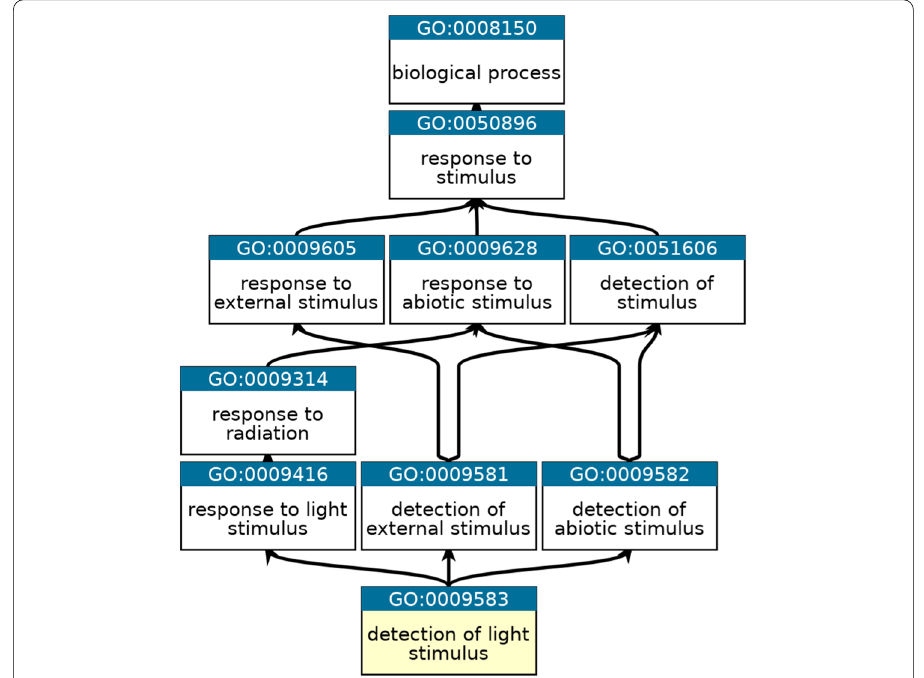
Fig. 3 Hierarchy for the biological process detection of light stimulus , represented as a DAG. Taken from QuickGO,